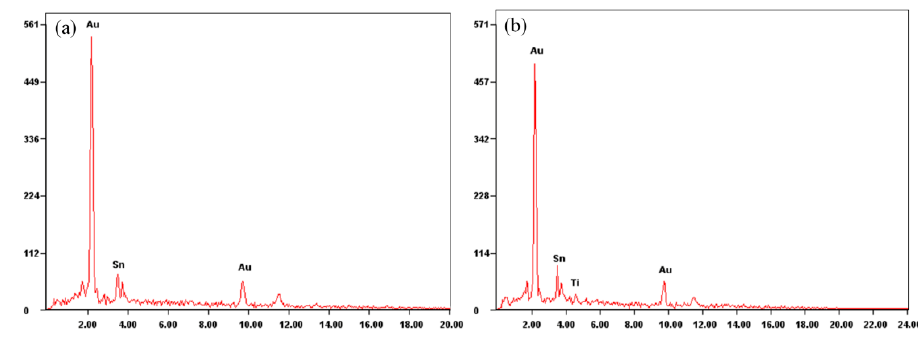
Figure 13. EDS analysis of the soldered MMIC after separation: ( a ) wetted area and ( b ) unwetted area.